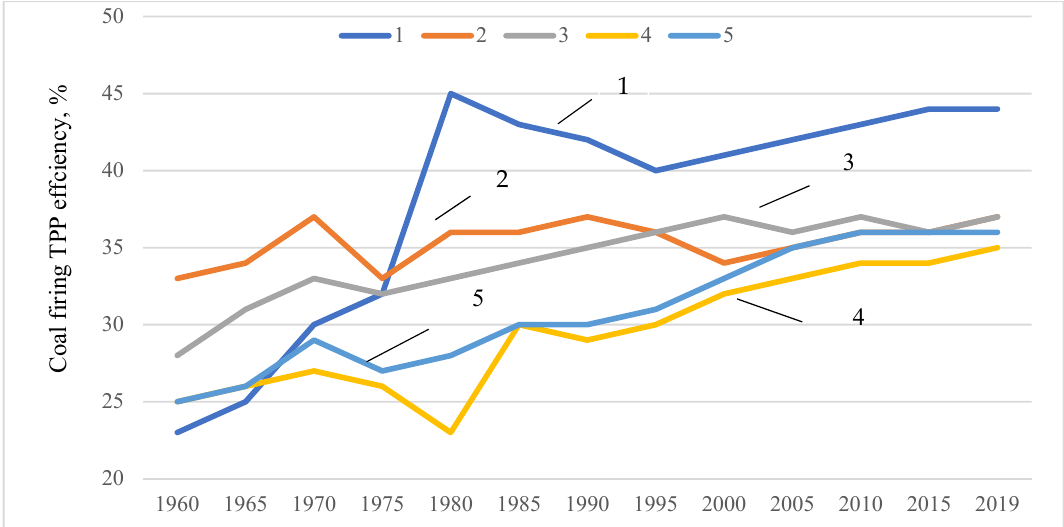
Figure 3. Coal-based power production in the countries with advanced power industries: 1—Japan, 2—USA, 3—Germany, 4—China, 5—Russia.